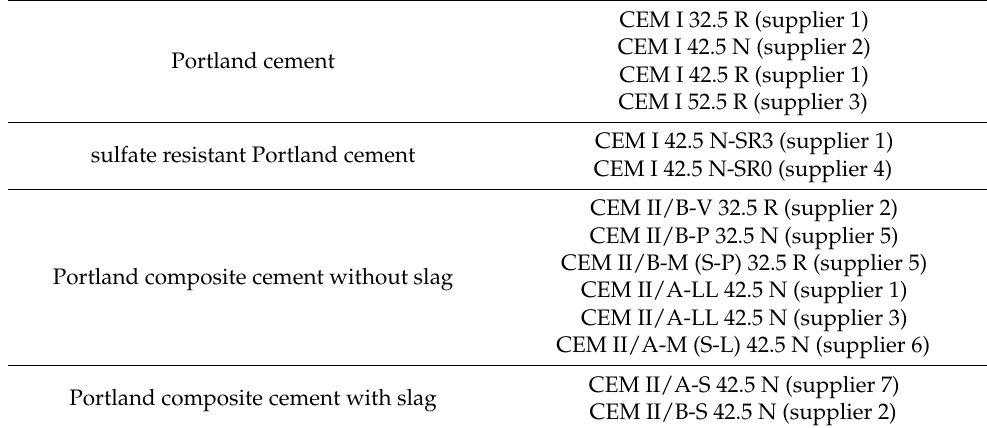
Table 1. Overview on the selected